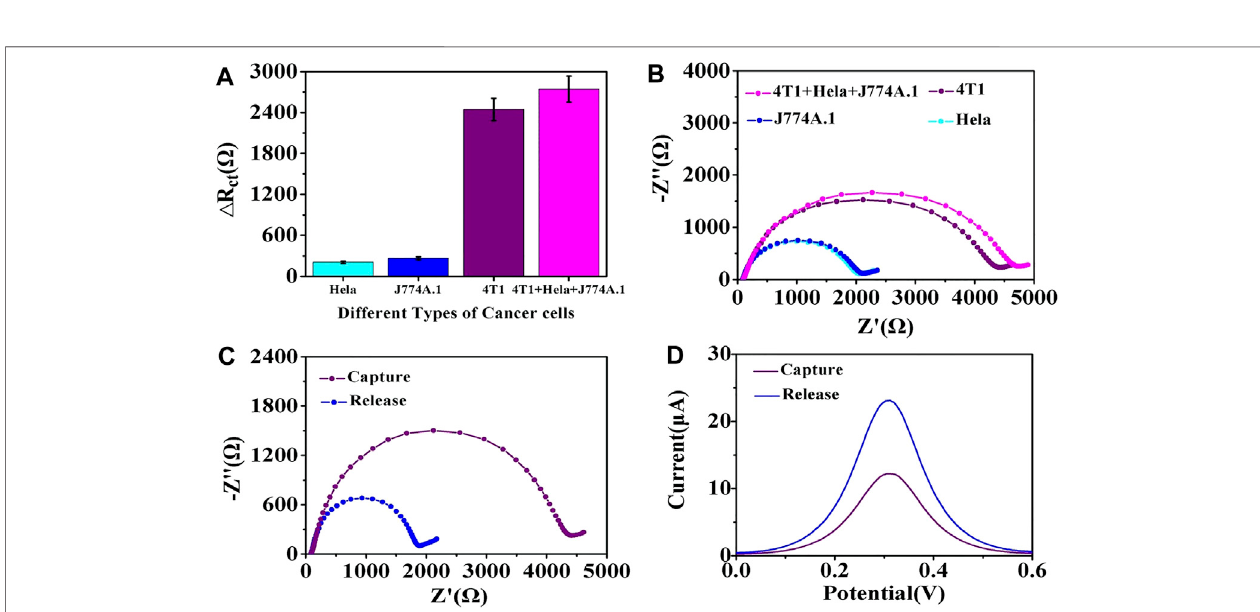
FIGURE 7 | (A) Speci fi city of the proposed cytosensing strategy, with the Δ R ct value of the G0 cytosensor after incubation with HeLa, J774A.1, or 4T1 cells measured in a solution containing [Fe(CN) 6 ] 3 − /4 − (5 mM, 1:1) and 0.1 M KCl. The error bars represent the standard deviation of fi ve replicate determinations. (B) typical EIS responsesafter capturing differenttypes ofcancer cells. (C) comparison oftheEIS results and (D) comparison oftheDPVresults ofthecytosensor after thecapture of cells and after the release of cells.